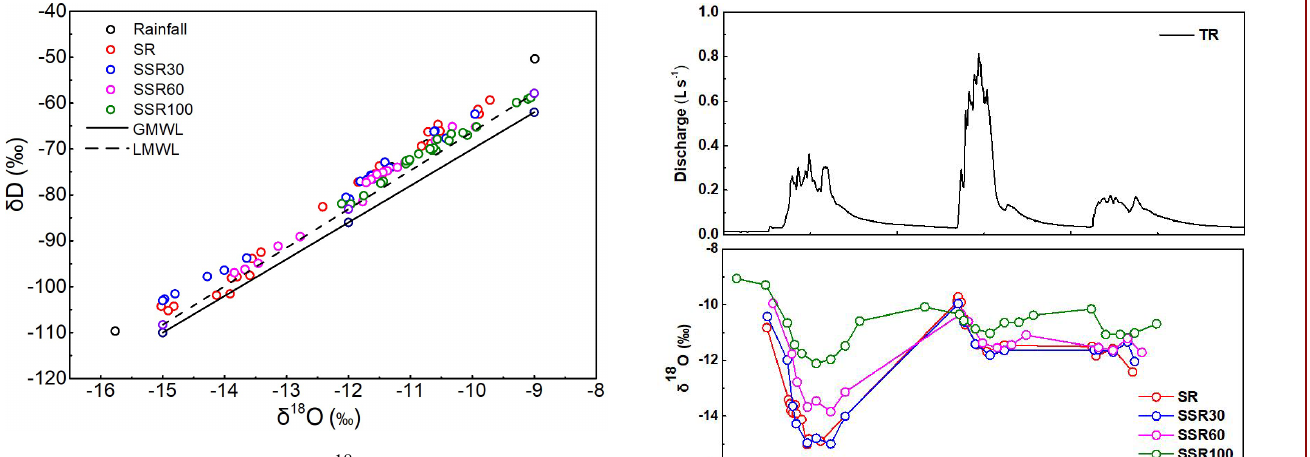
Figure 4. Relationship between δ 18 O and δ D in rainfall, SR, SSR30, SSR60 and SSR100. GMWL: Global Meteoric Water Line (Craig, 1961); LMWL: Local Meteoric Water Line (Tan et al., 2009).